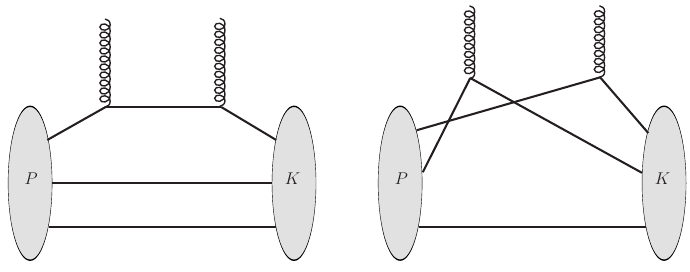
Figure 1: Handbag (left) and cat’s ears (right) diagrams at LO. The former (latter) dominates for small (large) momentum transfer | t |